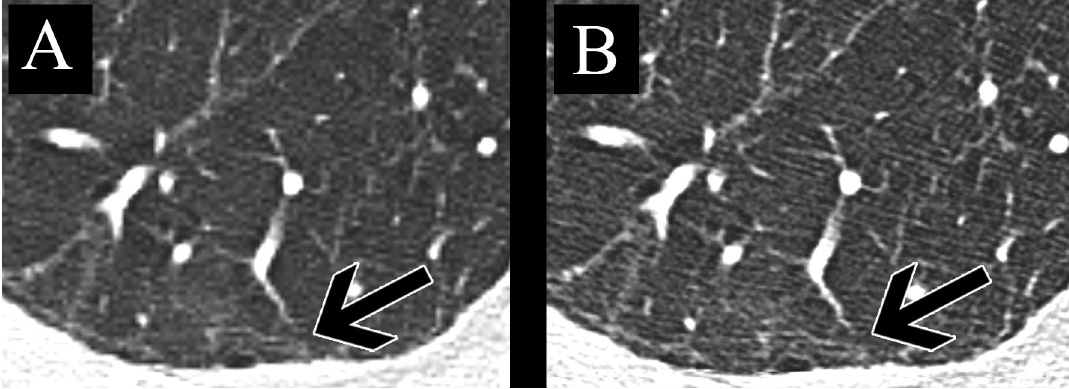
Fig 7. Image examples of a 67-year-old man imaged for interstitial pneumopathy. Axial CT slice reconstructed with a 512-matrix (A) and 1024-matrix (B). Fibrotic changes (black arrow) appear to be sharper in B compared to A. Objective and subjective image noise are inferior in